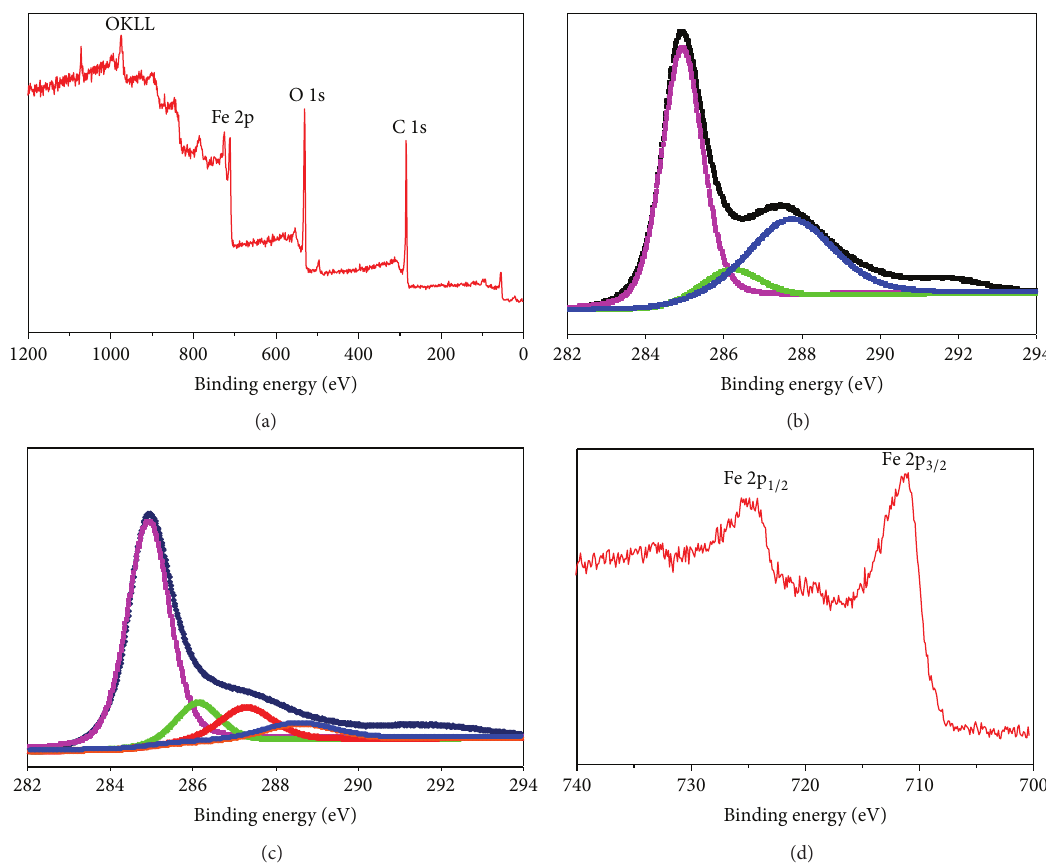
Figure 4: XPS spectrum of Fe 3 O 4 /rGO (a), XPS C 1s core level spectrum of GO (b), XPS C 1s core level spectrum of rGO (c), and XPS Fe 2p core level spectrum of Fe 3 O 4 /rGO (d).